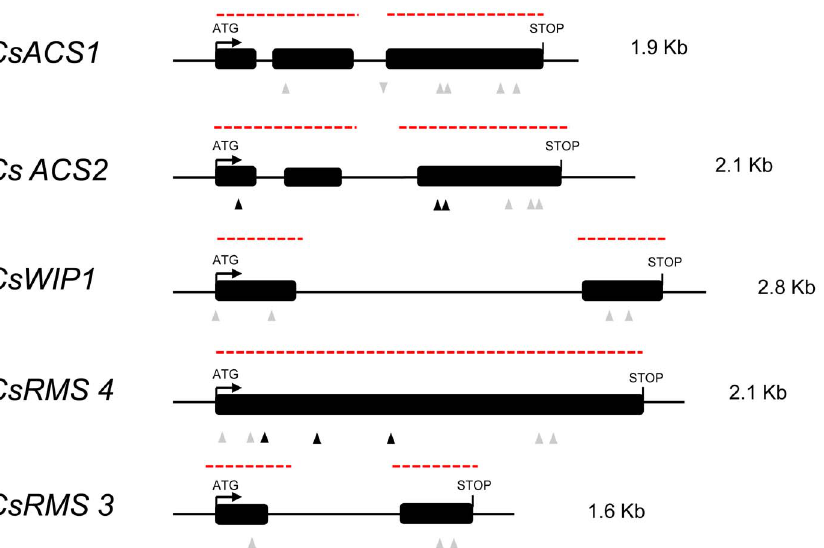
Figure 1. Structure of genes screened for mutations. Black boxes represent the exons. Lanes linking exons indicate introns. Dashed lines in red indicate the genomic regions screened for mutations. Triangles pointing up indicate mutations in coding regions, whereas triangles pointing down indicate mutations in intron. Black and grey triangles represent alterations causing missense and silent mutations, respectively.